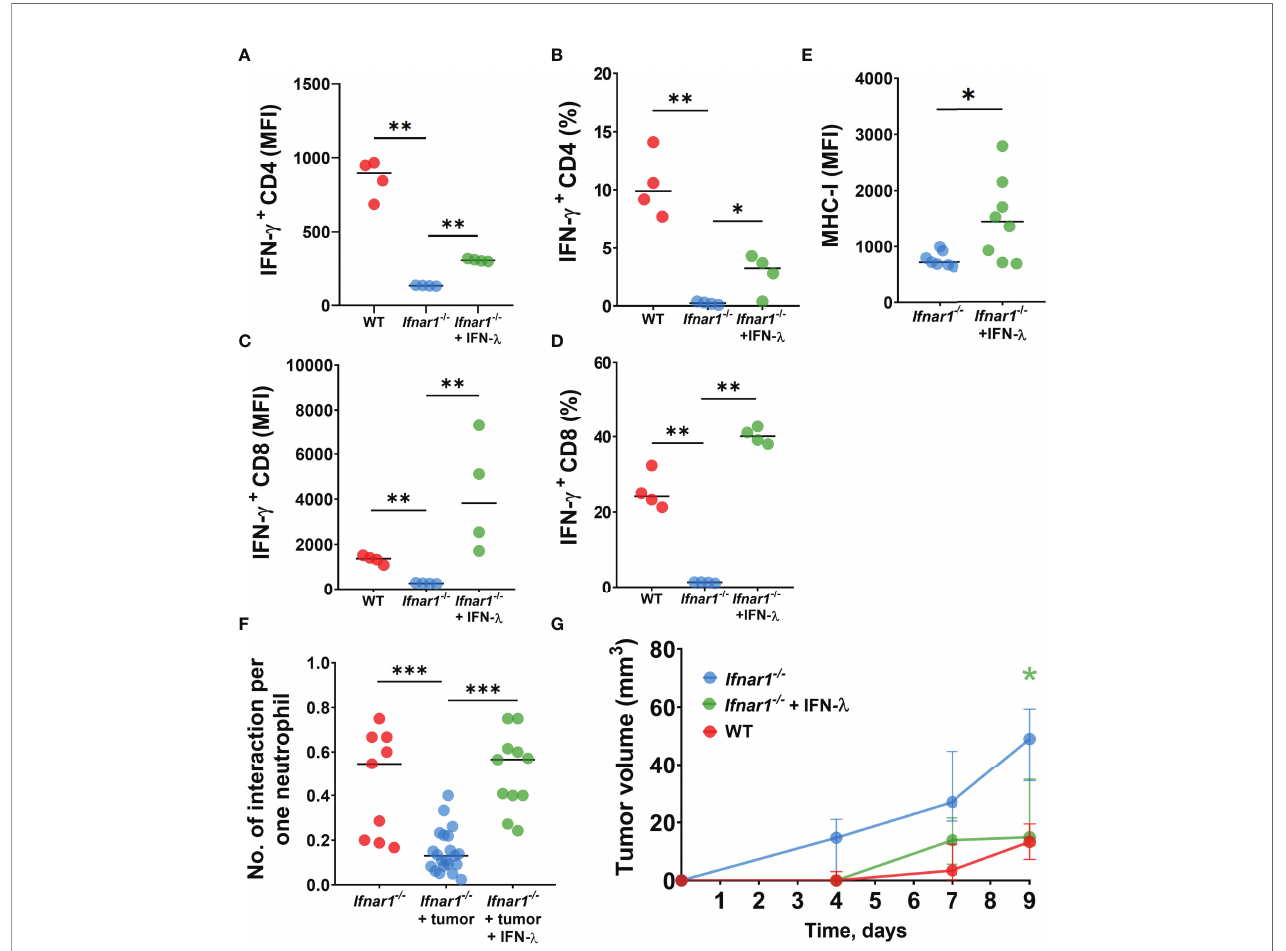
FIGURE 5 | IFN- l treatment increases neutrophil/T-cell interactions, activates T-cell and reduces tumor growth. (A – D) LN neutrophils from Ifnar1 -/- tumor-bearing mice after in vitro treatment with IFN- l signi fi cantly improved their capacity to stimulate IFN- ɣ production by T-cells. (E) Upregulation of MHC-I expression on TDLN- in fi ltrating Ifnar1 -/- neutrophils after in vivo treatment with IFN- l . (F) Enhanced numbers of interactions between neutrophils and T-cells in TDLNs in in vivo IFN- l treated Ifnar1 -/- mice. (G) Signi fi cantly decreased tumor growth in in vivo IFN- l treated Ifnar1 -/- mice. For (A – D) tumor cells were injected s.c. into the fl ank of mice. Mice were sacri fi ced on day 14 post tumor induction, LNs were collected, neutrophils (single alive Ly6G + CD11b + cells) were isolated using fl ow sorting and treated with IFN- l . T-cells (single alive CD3 + cells) were isolated from the spleens of naïve WT mice using fl ow sorting and co-incubated with pre-treated neutrophils. On day 3 the intracellular expression of IFN- ɣ in single alive CD4 + and CD8 + cells was estimated by fl ow cytometry. Representative results from one experiment are shown for (A – D) , n=15 for WT animals, n=14 for Ifnar1 -/- animals. Isolated LN neutrophils were pooled and divided in three groups. For (E, F) tumor cells were injected s.c. into the fl ank of mice and treatment with IFN- l was applied at days 13 and 14 (24 hours and 1 hour before the imaging procedure). Mice were sacri fi ced on day 14 post tumor induction, LN were collected and MHC-I expression on neutrophils (single alive Ly6G + CD11b + cells) was estimated by fl ow cytometry (E) . Representative results from two replicate experiment are shown for (E) , n=6 for WT animals, n=7 for Ifnar1 -/- animals. Two-photon microscopy of the previously surgically exposed inguinal lymph node was performed on day 14 and cell interactions were manually counted in ROIs over the duration of 15 minutes (F) . Representative results from four replicate experiments are shown for (F) , n=5 Ifnar1 -/- animals, n=8 Ifnar1 -/- tumor-bearing animals, n=4 IFN- l treated Ifnar1 -/- tumor-bearing animals. For (G) tumor cells were injected s.c. into the fl ank of mice. Treatment with IFN- l was applied during the tumor progression and tumor volume was measured. Mice were sacri fi ced on day 9 post-tumor induction. Representative results from two replicate experiment are shown for (G) , n=5 for each cohort. For comparison of two independent groups, Mann-Whitney U test was used, and for comparison of multiple independent groups Kruskal-Wallis (ANOVA) was used. Data are shown as median with interquartile range (G) and individual values with median (A – F) . *p < 0.05, **p < 0.01, ***p <